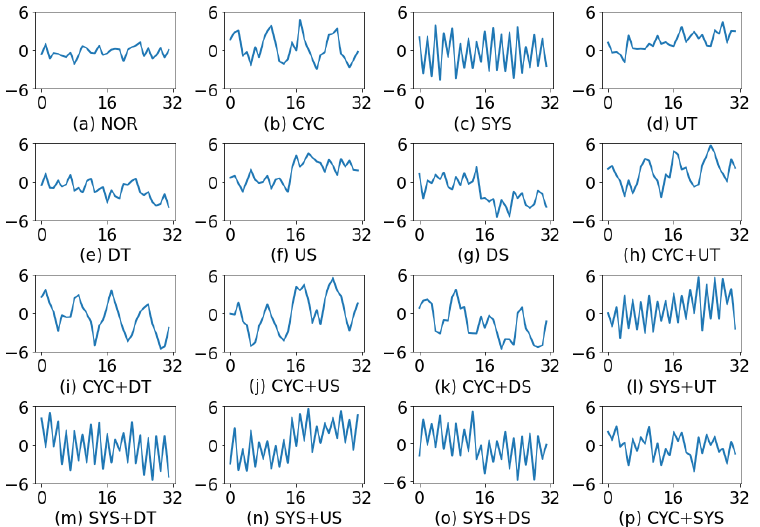
Figure 5. Single and concurrent patterns.